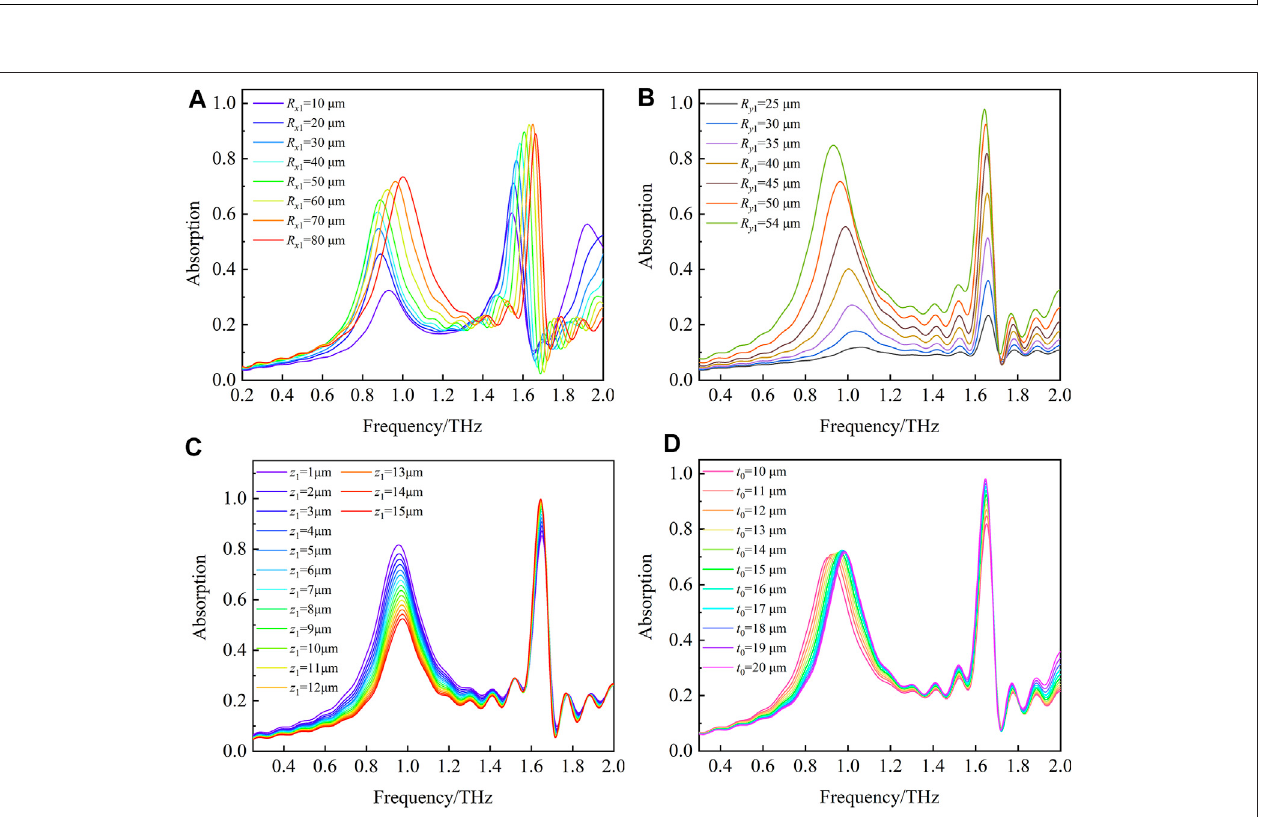
FIGURE5|(A) TheabsorptionspectrawiththemajoraxisradiusoftheellipticalporeintheCNTs fi lm R x 1 increasingfrom10to70 μ m,where R y 1 is fi xedas50 µm. (B) The absorption spectra with the minor axis radius of the elliptical pore in the CNTs fi lm R y 1 increasing from 25 to 54 μ m, where R x 1 is fi xed as 70 µm. (C) The absorption spectra with different thickness of the CNTs fi lm z 1 . (D) The absorption spectra of the CMMC with the height of the micro fl uidic channel increasing from 10 to 20 µm.